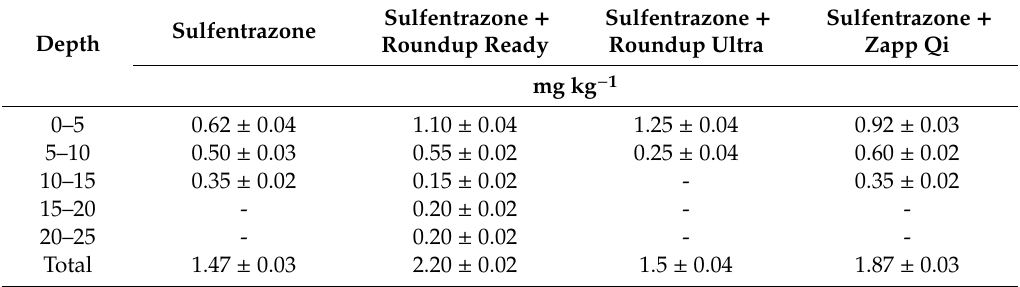
Table 6. Sulfentrazone concentrations (mean ± interval of confidence) in the column profile submitted to sulfentrazone application in isolation and mixed with formulations of glyphosate: Roundup Ready ® , Roundup Ultra ® , and ZappQi ® .